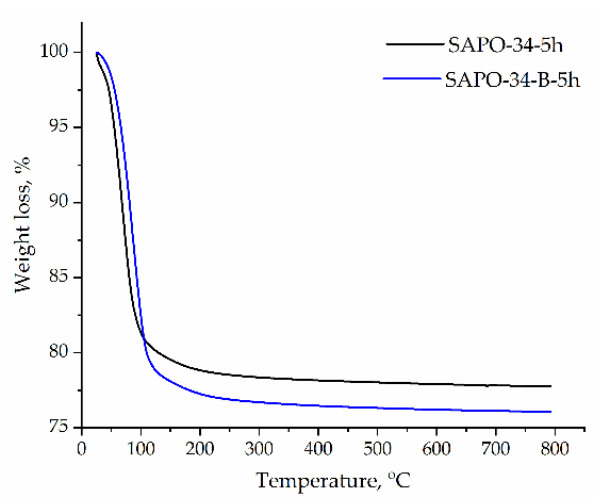
Figure 5. TG analysis of SAPO-34 samples synthesized from AIP (SAPO-34 − 5h) and boehmite (SAPO-34 − B − 5h).